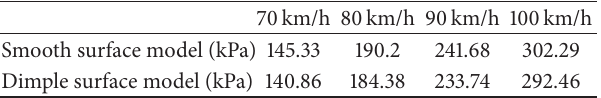
Smooth surface model (kPa) 145.33 Dimple surface model (kPa)